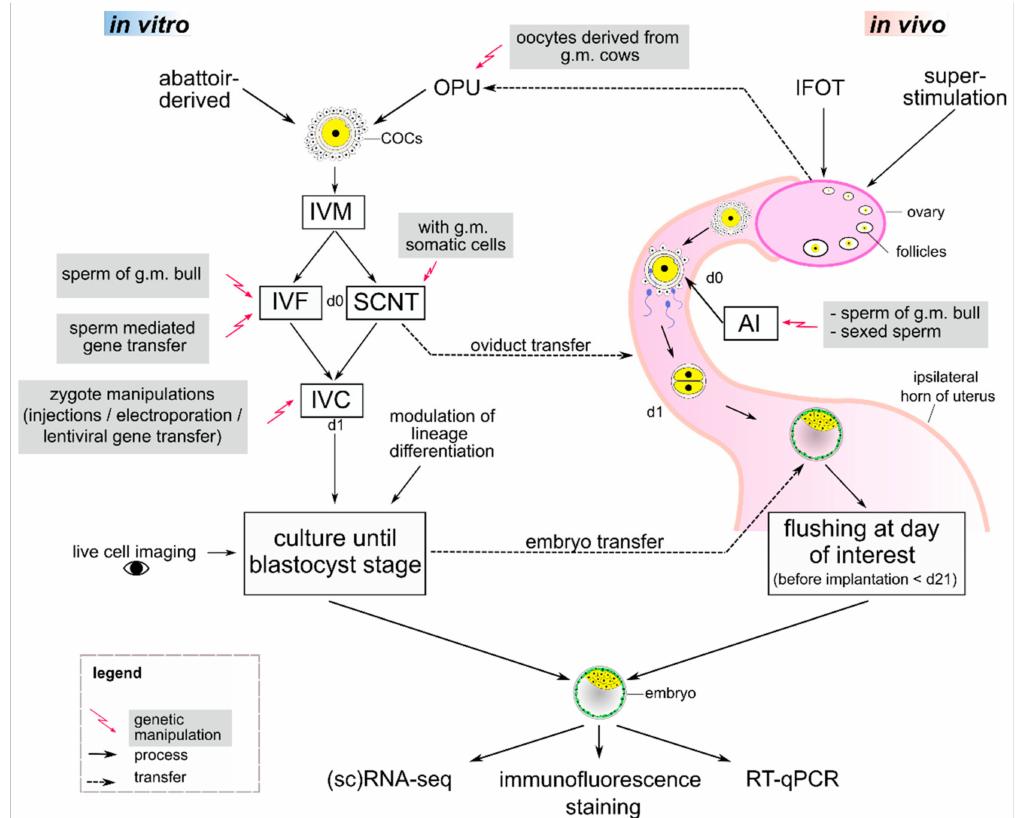
Figure 1. Studying preimplantation development with combined artificial reproduction technologies (ARTs) and genetic ma- nipulation tools in cows. For in vitro production, cumulus-oocyte complexes (COCs) can either be derived from the abattoir or by ovum pick-up (OPU), where oocytes from genetically modified (g.m.) cows may be used. After in vitro maturation (IVM) of COCs, oocytes are in vitro fertilized (IVF) or reconstructed embryos from somatic cell nuclear transfer (SCNT) are activated, marking day 0 (d0) of embryo development. To study preimplantation development, genetic modifica- tions can be introduced during IVF via sperm, by using g.m. donor cells in SCNT, or by direct manipulation of zygotes. These modifications enable, e.g., reverse genetics studies of specific gene functions or tagging of lineage-specific proteins with fluorescent markers. Embryos can then be transferred into the oviduct of a cow or cultured in vitro from day 1 (d1) until day 8. During culture, modulation of lineage differentiation and live cell imaging is feasible. If later stages are of interest, embryo transfer into the uterus can be carried out on day 7. For in vivo production, intrafollicular oocyte transfer (IFOT) or superstimulation increase the oocyte yield and artificial insemination (AI) with g.m. or sexed sperm can be performed. After in vivo development, embryos may be flushed non-surgically from the uterus at the day of interest until shortly before implantation on day 21 (d21). Embryos derived from in vitro or in vivo can be further examined by (single-cell) RNA-sequencing ((sc)RNA-seq), immunofluorescence staining or reverse transcriptase-quantitative PCR